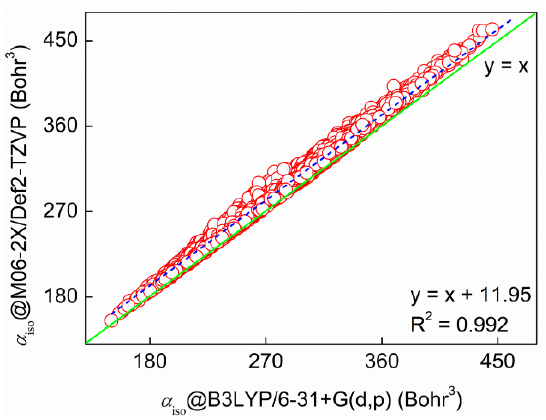
Figure 3. Cross-validation of molecular polarizabilities of 8000 tripeptides carried out at the M06- 2X/Def2-TZVP//M06-2X/Def2-SVP and B3LYP/6-31+G(d,p)//B3LYP/6-31G level, respectively.